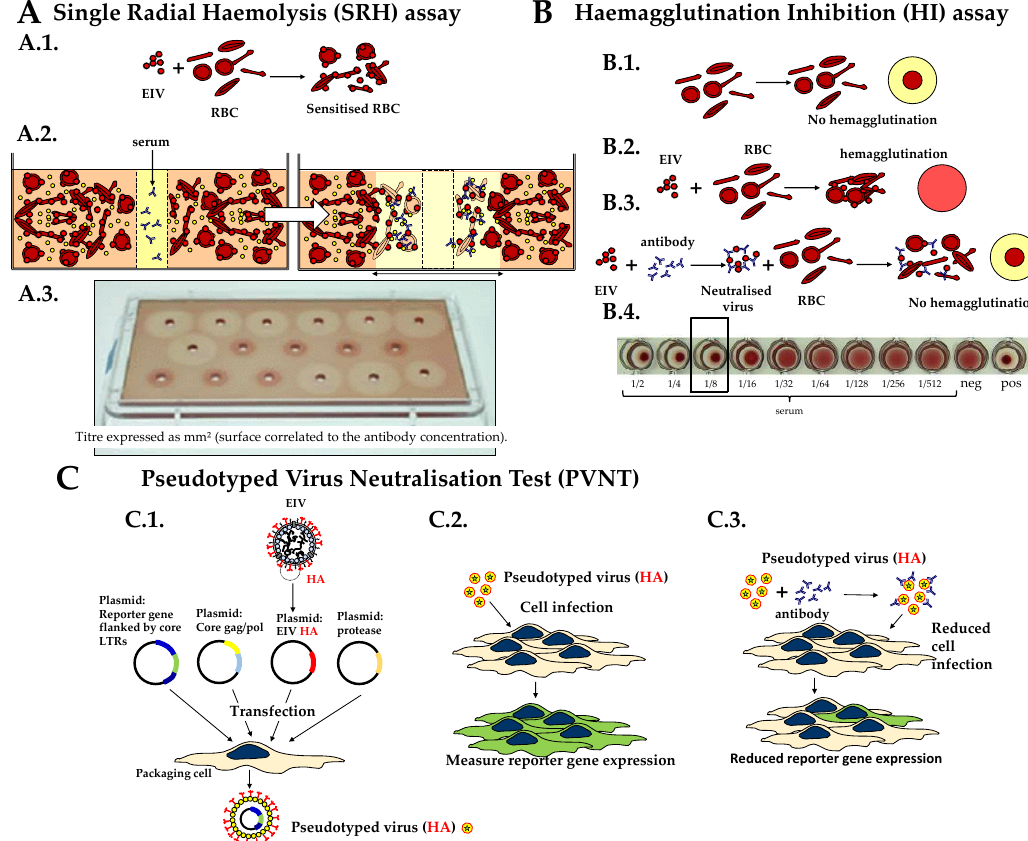
Figure 1. Serological assay / tests to measure equine influenza virus (EIV)-specific antibody response. ( A ) Single radial haemolysis (SRH) assay: (A.1.) sheep red blood cells (RBCs) are sensitized with EIV, (A.2.) EIV-sensitized RBCs are mixed with guinea-pig complement and melted agar, and (A.3) poured onto an immunoplate. When the gel is set, 10 µ L of heat-inactivated undiluted serum is placed in the punched hole. The plate is incubated for 20 to 24 h at 30 ◦ C to allow serum diffusion prior to measurement of the haemolysis area. ( B ) Haemagglutination inhibition (HI) test: (B.1.) in the absence of EIV, chicken RBC sediment to the bottom of round-bottomed wells of a 96-well plate; (B.2.) in the presence of EIV and RBC agglutinate; (B.3.) the incubation of EIV with a serum containing EIV-specific antibody prevents the RBC agglutination; (B.4) an example of a serum titration (i.e., HI titer of 1:8). ( C ) Pseudotyped virus neutralisation test (PVNT), adapted from ref [9]: (C.1.) to generate lentivirus pseudotypes, four plasmids expressing EIV HA, HIV gag-pol, firefly luciferase reporter gene, and an HA-cleaving protease (e.g., TMPRSS2) are transfected into a packaging cell. EIV HA pseudotyped particles are released in the supernatant, harvested, then titrated on an influenza-permissive cell line. (C.2.) The level of reporter gene expression is measured in this target cell culture. (C.3.) The pre-incubation of influenza HA-pseudotyped virus with a serum containing EIV-specific antibody reduces cell infection and the associated reporter gene expression.